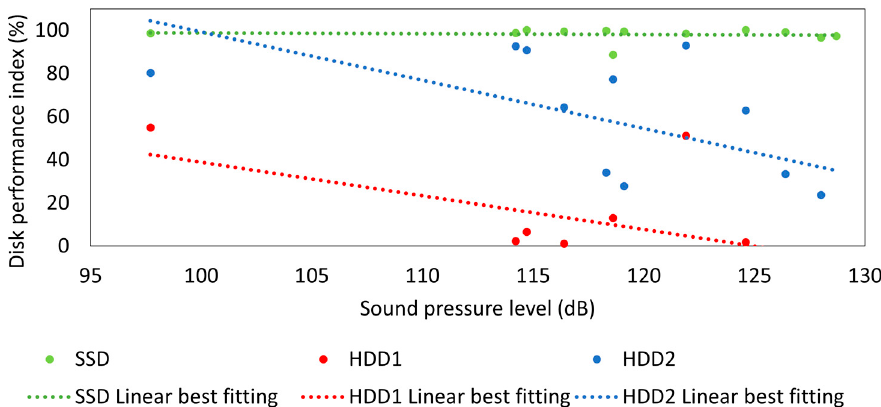
Figure 9. Performance index as a function of maximum SPL reached in every tested condition with nitrogen IG100.